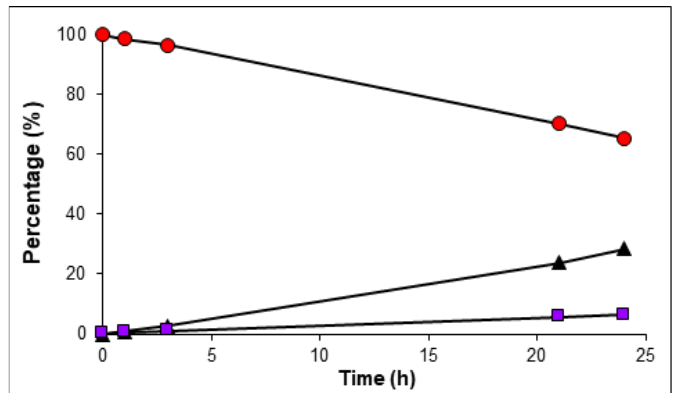
◦ C. The radioligand was slowly epimerized